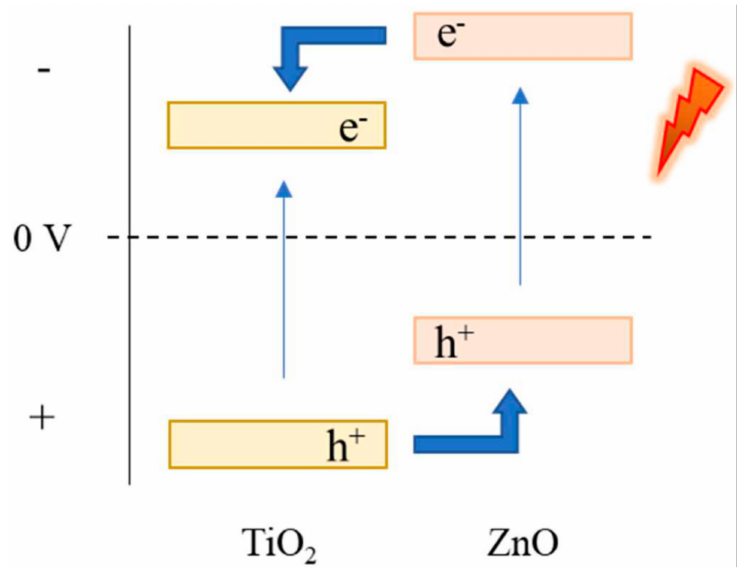
Figure 1. Schematic diagram of the energy level for heterojunction of TiO 2 /ZnO hybrid